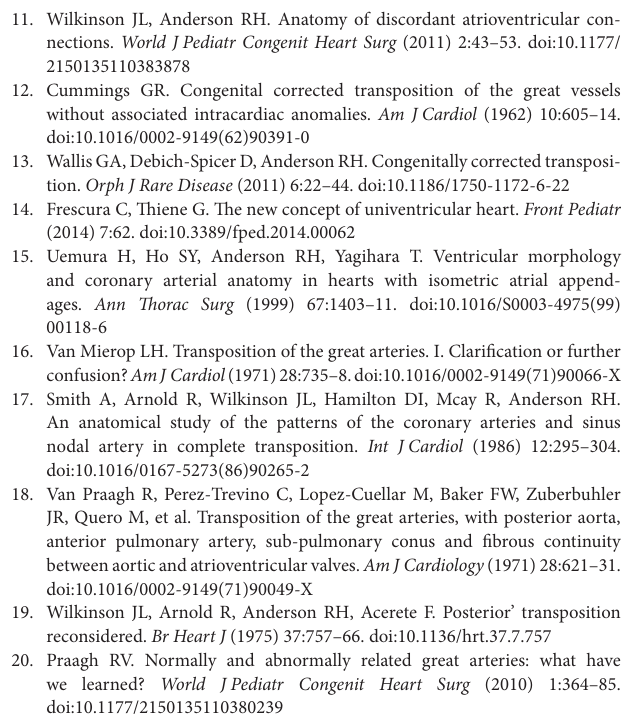
some cases of complete TGA with situs solitus, and it is the rule in cases of complete TGA in situs inversus. This is another good reason to rule out the term